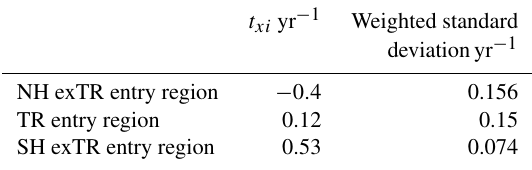
Table 1. t xi and standard deviations for SF 6 mixing ratio time se-